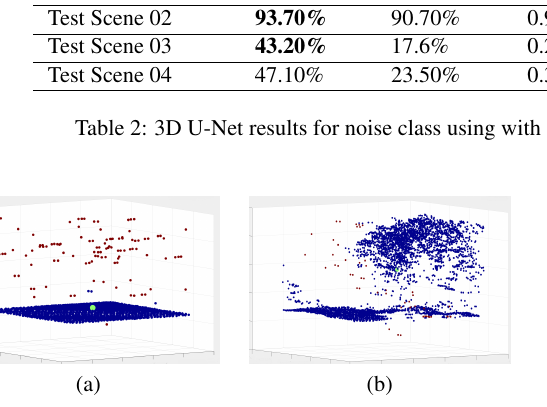
Figure 9: Two voxels from one scene, a) sparse noise far from the terrain, b) complex noise overlapping with bushes; red: noise points, blue: regular points and green: centroid